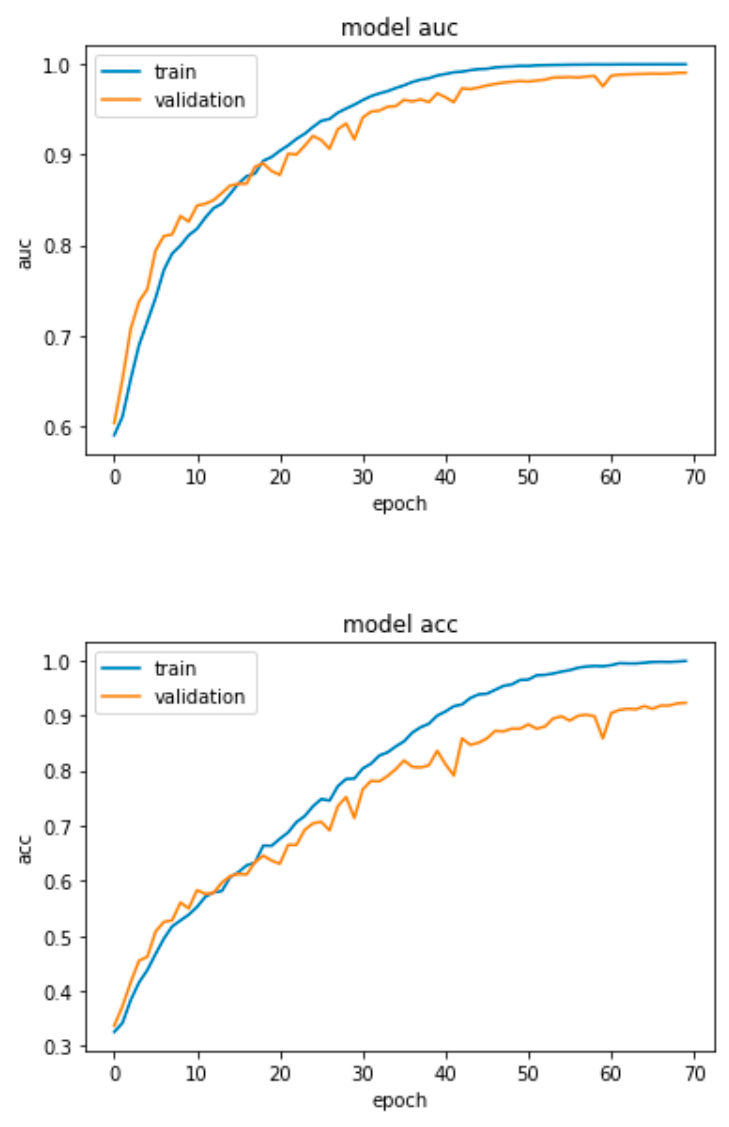
Figure 2. Proposed DRL-XGBOOST Accuracy and AUC.